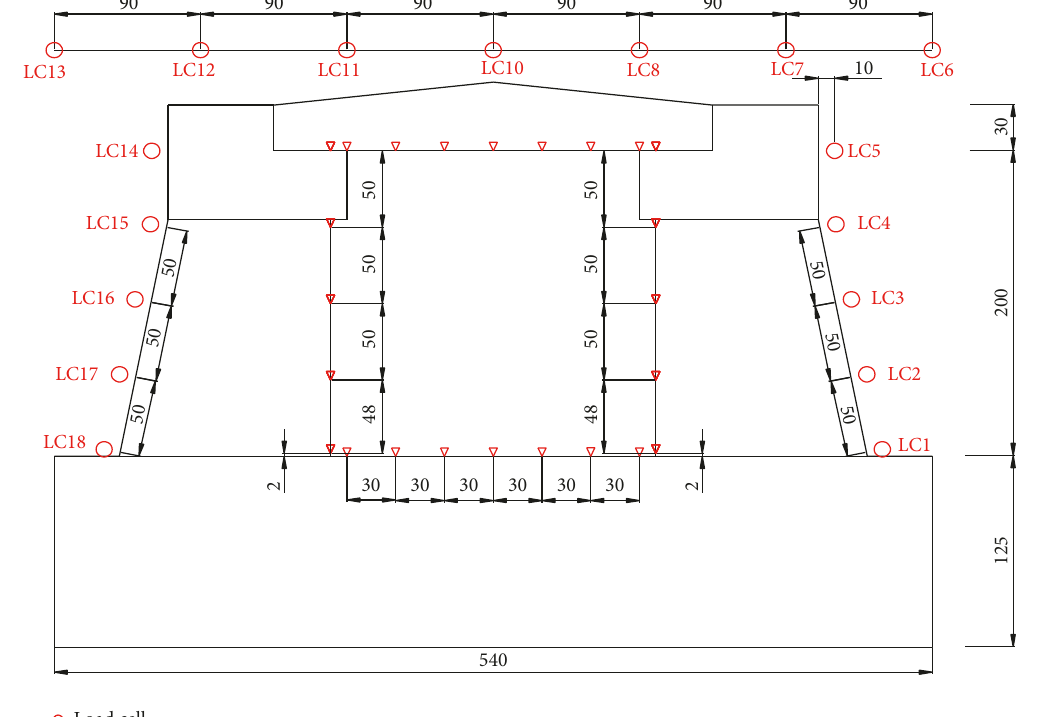
Figure 4: Test section and instrument layout of culvert (unit: cm).